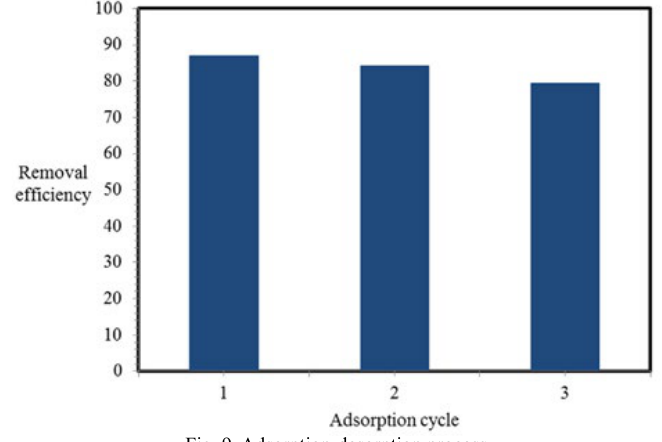
Figure 9. Adsorption-desorption process